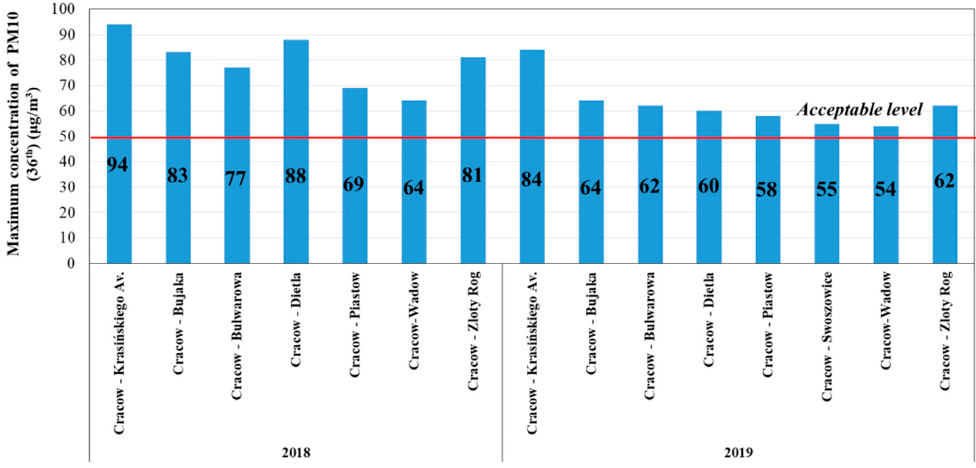
Figure 5. Maximum concentration of PM10 (36th) in Wroclaw [31,32].